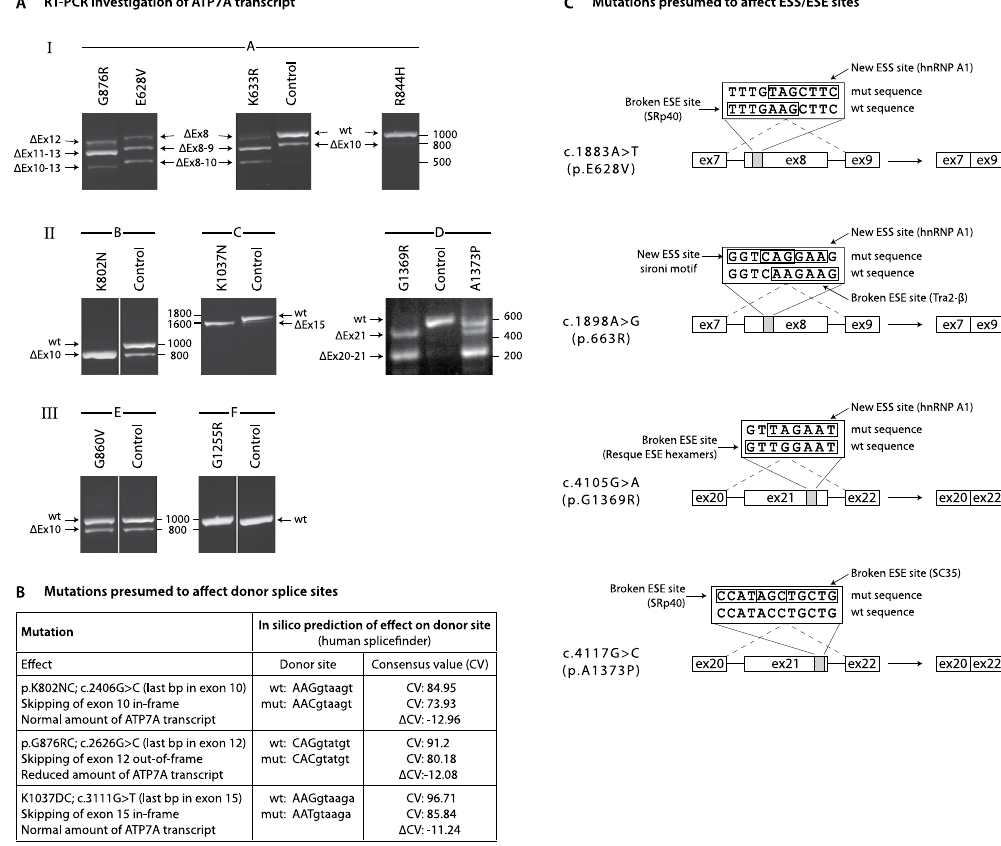
Figure 5. ( A ) RT-PCR investigation of ATP7A transcript. RNA from MD fibroblasts were subjected to RT- PCR spanning the exons with the missense mutations. Control samples are from a normal control. Size (in bp) of marker DNA fragments are indicated. The PCR products were separated by gel electrophoresis, purified and sequenced (Table 1). Primers are given in Supplementary Table 2. (I) No detectable ATP7A protein and a reduced amount of ATP7A transcript. A: PCR amplification of exons 7–14. E628V C and K633R C (mutations in exon 8); skipping of exon 8, exons 8–9 or exons 8–10. G876R C (mutation in exon 12); skipping of exon 12,